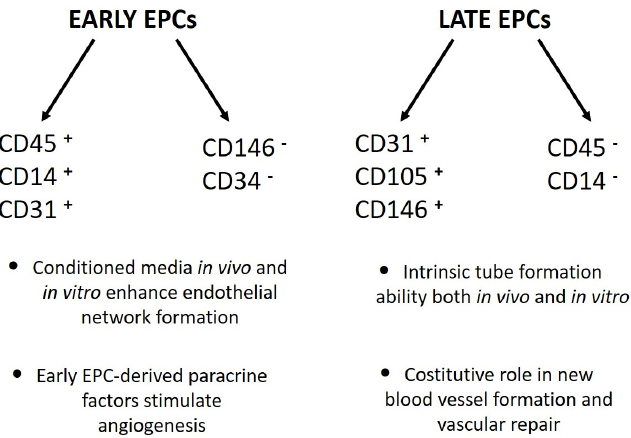
Figure 1. Phenotypical and functional differences between “early” and “late” EPCs [12,13,14].